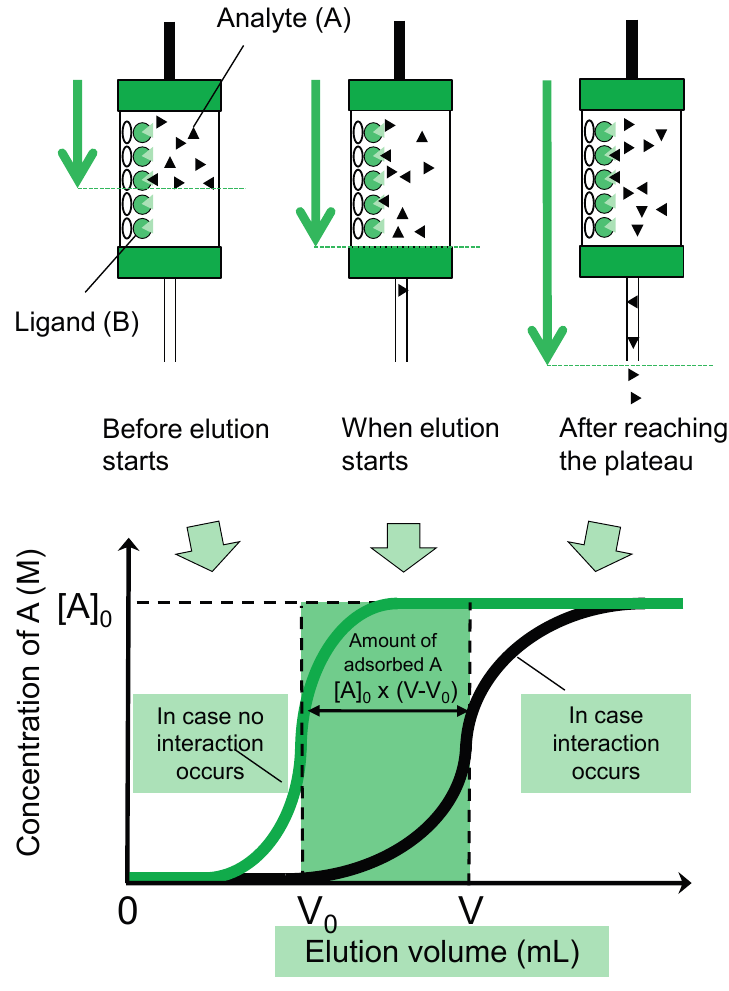
Figure 2. A schematic drawing of an FAC procedure and resultant elution